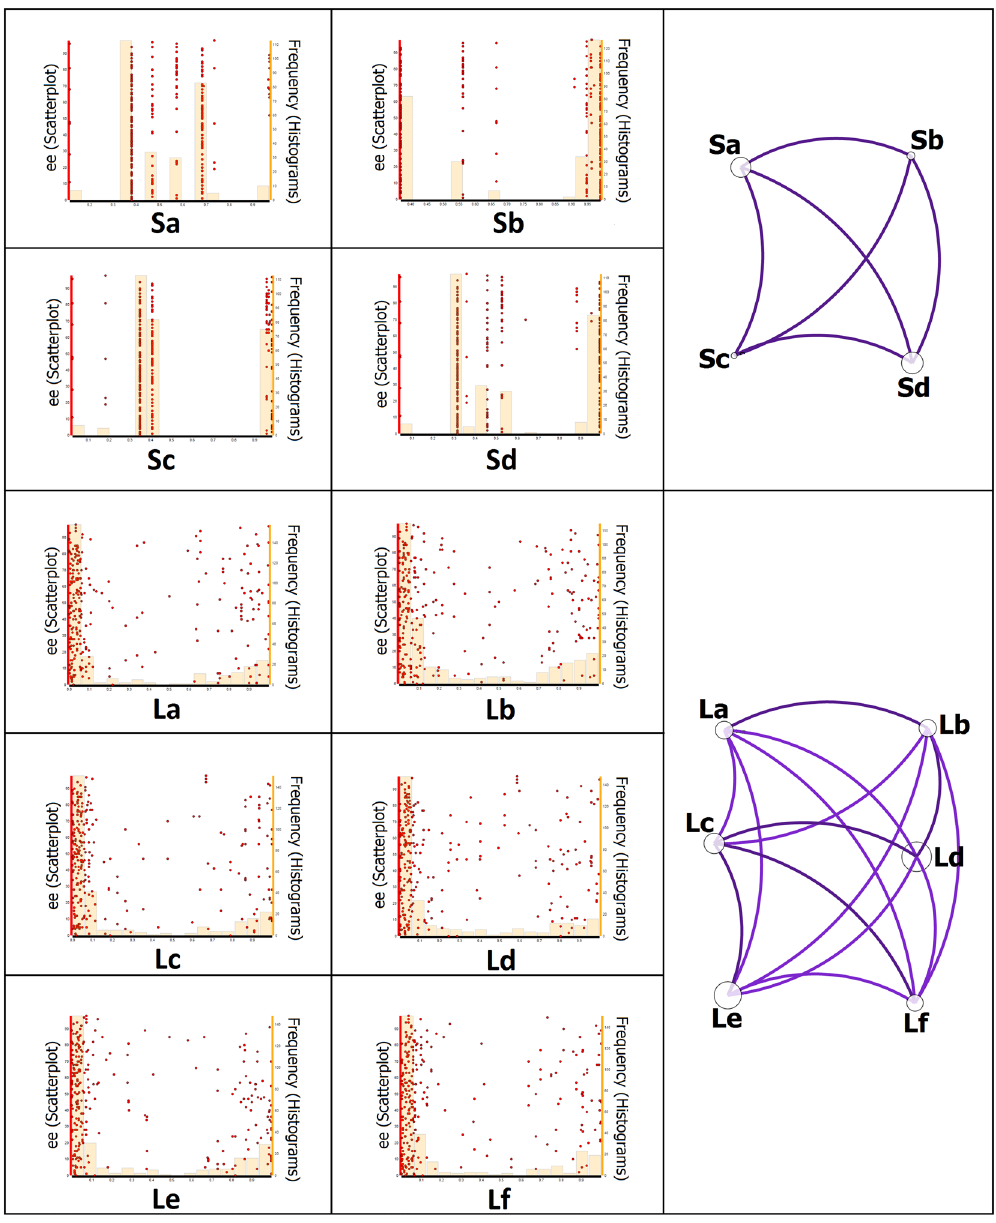
Figure 10. Relationship among the molecular descriptors computed by CODES-TSAR ( CT EE subset) and the target